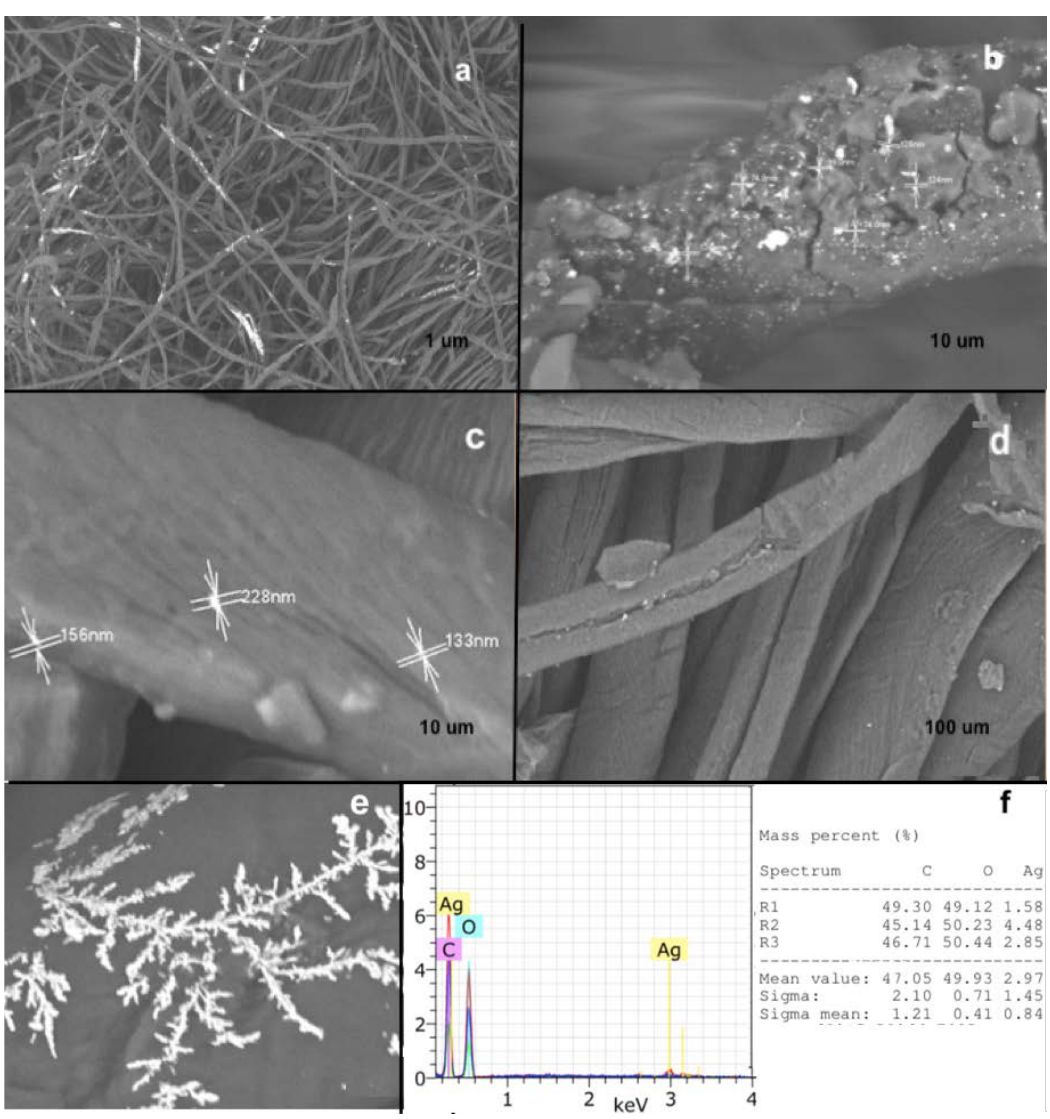
Figure 3. SEM-STEM analysis of the cotton fabric covered in L -Cys-AgNPs ( a , b ); the cotton fabric covered in bio-AgNPs ( c , d ); and the control ( e ). In addition, EDX spectra ( f ) displaying the compo- sition of the L -Cys-AgNPs at pH 8.6 and the presence of a peak at 3 keV characteristic for Ag, as determined by the Ag L α lines. determined by the Ag L α